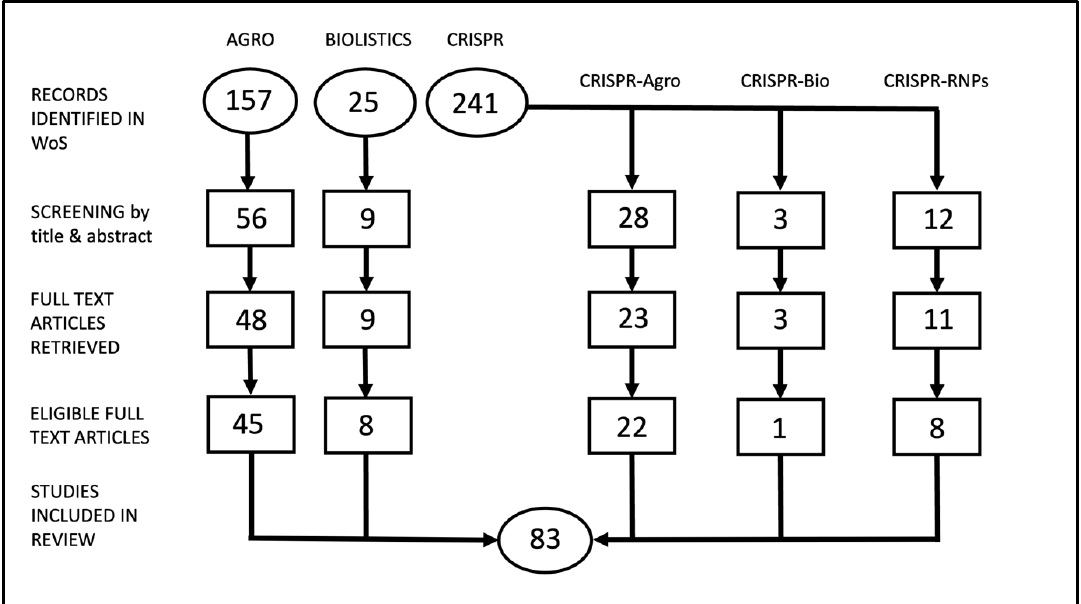
Figure 1. Flowchart of record retrieval and filtering used in the systematic literature review. Agro = Agrobacterium -mediated gene transfer. Bio = Biolistics. CRISPR = CRISPR-Cas9. RNPs = ribonucleoproteins.